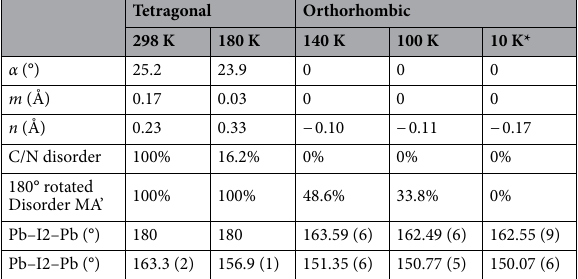
Tetragonal Orthorhombic